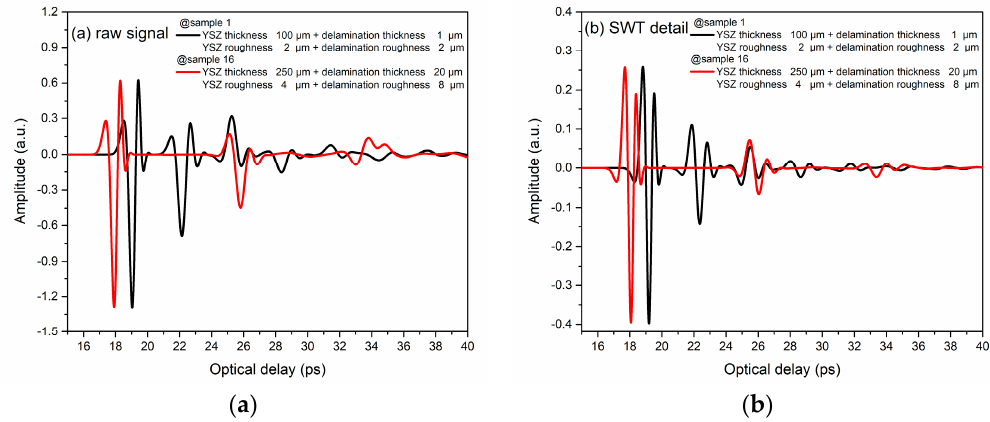
Figure 6. Terahertz time domain signals of sample 1 and sample 16: ( a ) raw signal; ( b ) SWT detail signal.